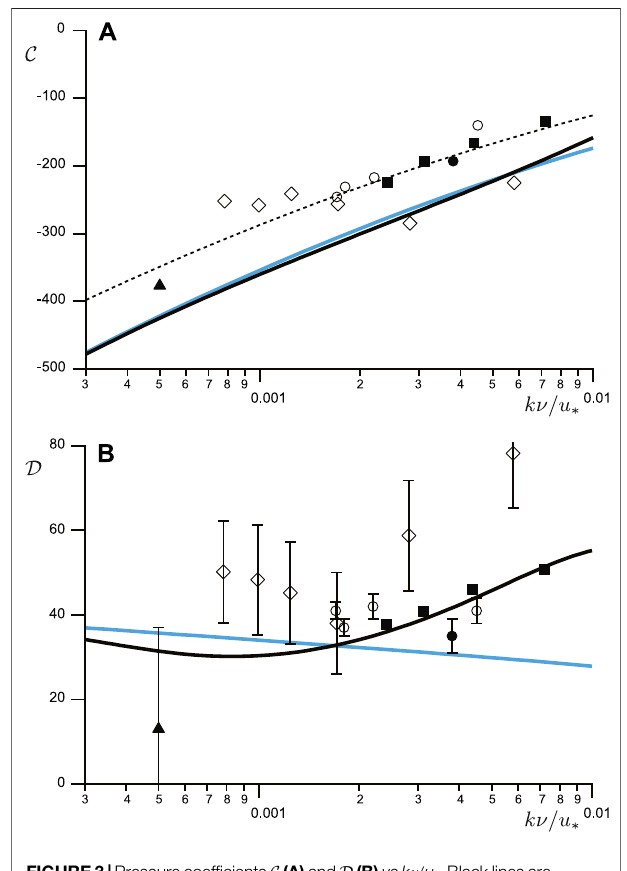
FIGURE3| Pressurecoef fi cients C (A) and D (B) vsk ] / u * .Blacklinesare theoreticalpredictionsforasmoothbed( Figure1 ).Thedottedlinein( A )isa fi t of the form C (cid:2) −( 1 / κ 2 ) ln 2 ( 2 π b / kz 0 ) with b x 0 . 02. Blue lines: theoretical predictions for a rough bed, with k ] / u * (cid:2) 7 kz 0 . Symbols, see Table 1 .